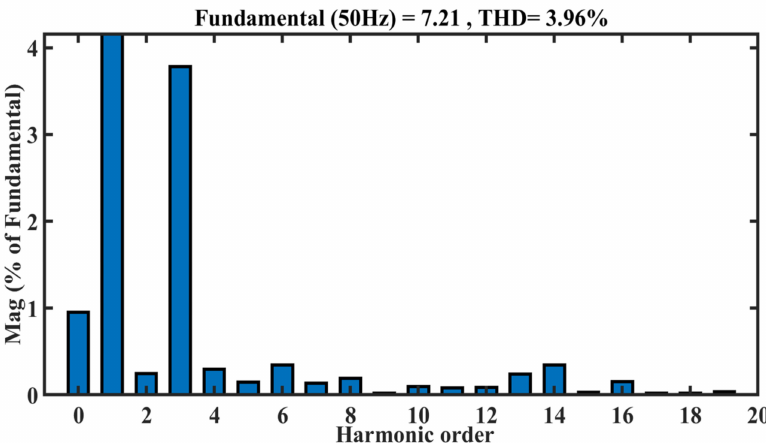
Figure 16. THD analysis of grid current waveform with PSO-PI